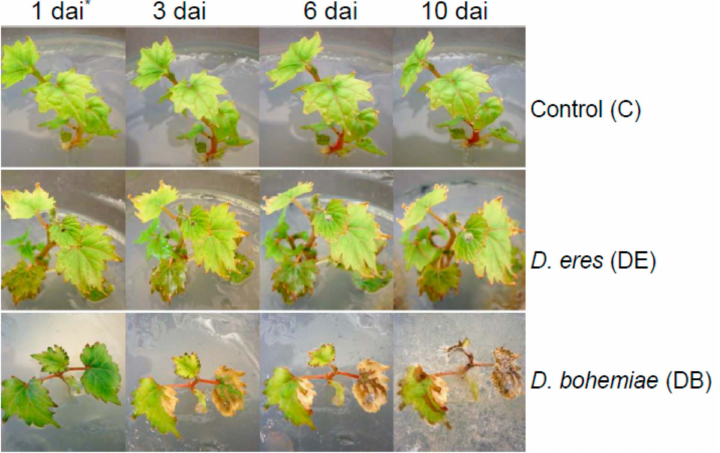
Figure 2. Treatments used in the study. * days after inoculation.